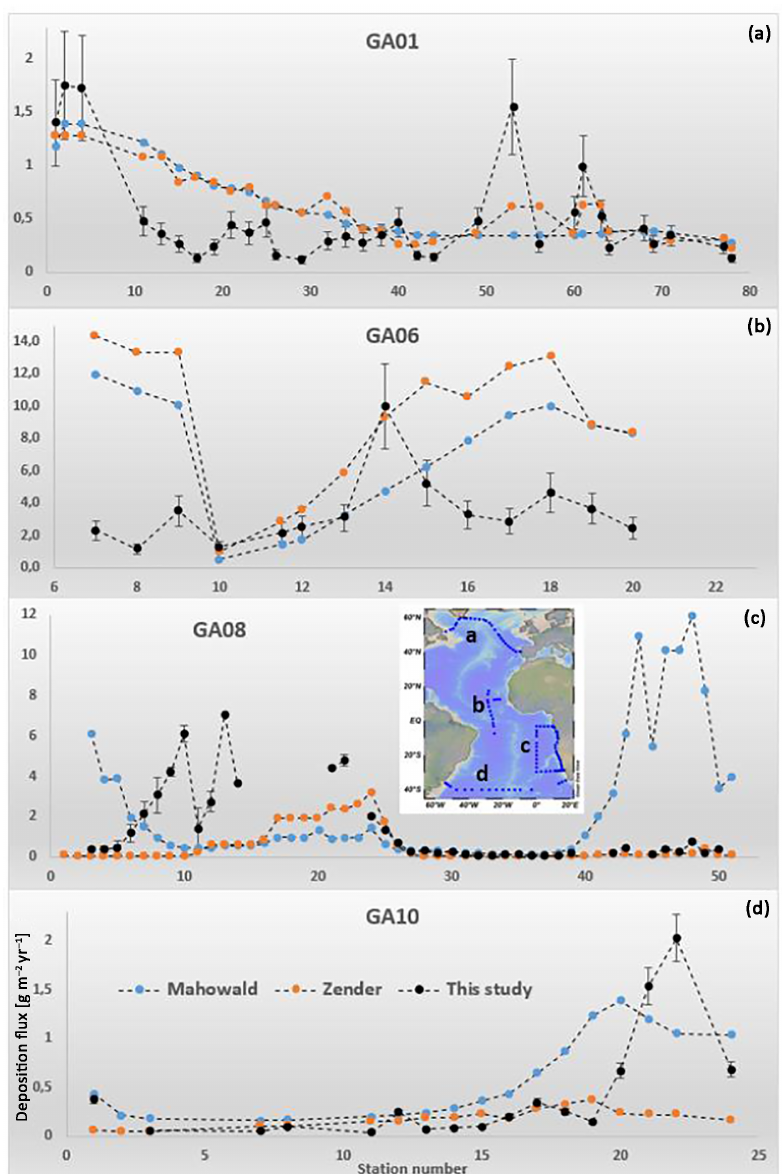
Figure 7. Total average atmospheric deposition fluxes (this study, black circles) and model atmospheric deposition estimates from Mahowald et al. (2005) (blue circles) and Zender et al. (2003) (orange circles). For stations numbers associated to each cruise please refer to Fig.